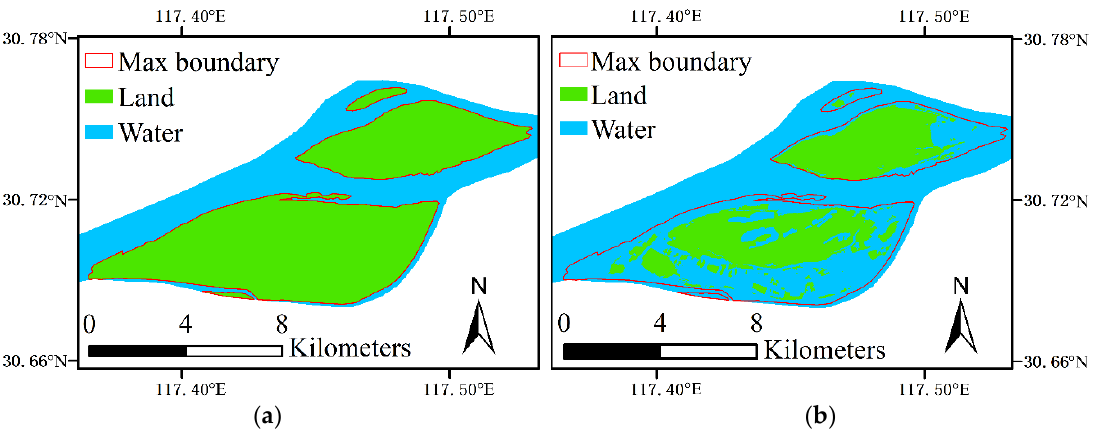
Figure 4. The maximum ( a ) and minimum ( b ) area of the river island.